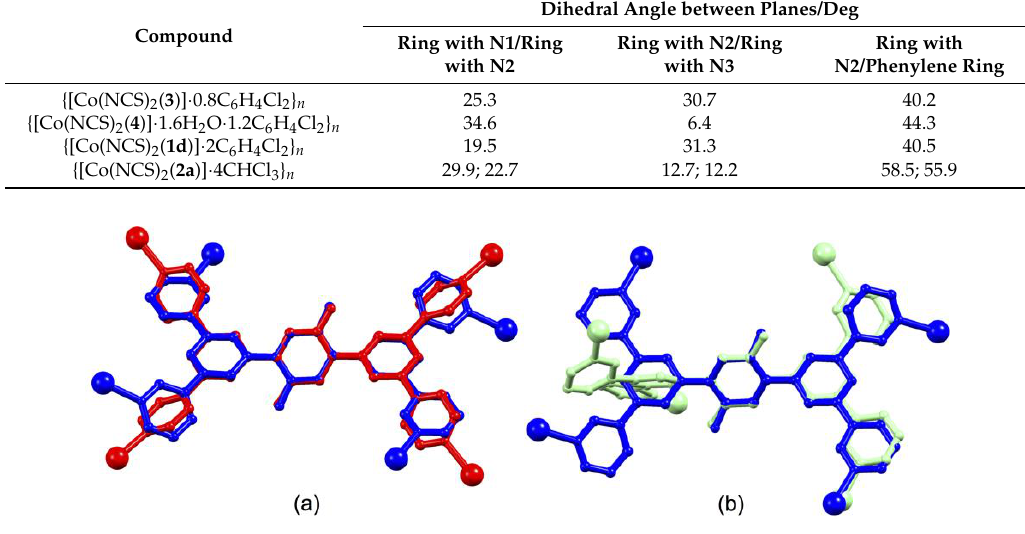
Figure 4. ( a ) Overlay of {Co 4 ( 3 )} and {Co 4 ( 4 )} units in {[Co(NCS) 2 ( 3 )]·0.8C 6 H 4 Cl 2 } n and {[Co(NCS) 2 ( 4 )] · 1.6H 2 O · 1.2C 6 H 4 Cl 2 } n ; ( b ) Overlay of {Co 4 ( 4 )} and {Co 4 ( 2a )} units in {[Co(NCS) 2 ( 4 )]·1.6H 2 O·1.2C 6 H 4 Cl 2 } n (this work) and {[Co(NCS) 2 ( 2a )]·4CHCl 3 } n [20]. In each overlay, the atoms of the central phenylene ring superimposed. For clarity, only the O atoms of the alkyloxy chains are shown.